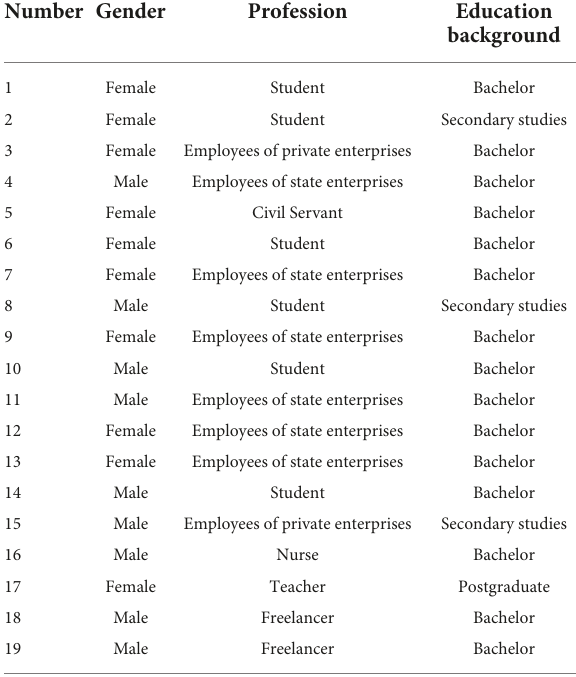
TABLE 1 Information of qualitative study